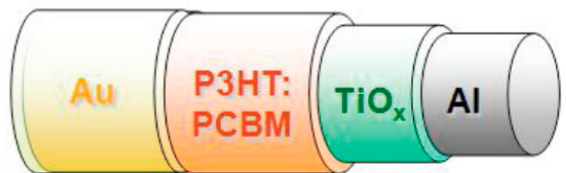
Figure 12. Schematic of a simple metal core based organic PV fiber. Reprinted from [140] with permission from Elsevier. This simple design has conducting inner and outer electrodes (Au and Al) and active layers (TiOx and P3HT:PCBM) forming the solar cell. This schematic provides a good example of a coaxial type solar cell, where the cell is built from multiple layers covering a core